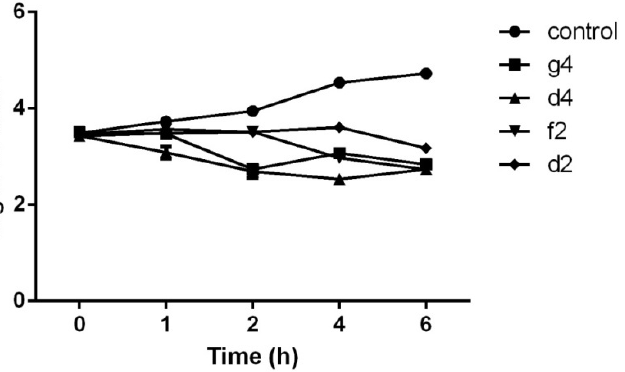
Figure 3. P. aeruginosa CFU (log10) after different time intervals of antimicrobial treatment with the MBC of tested compounds.